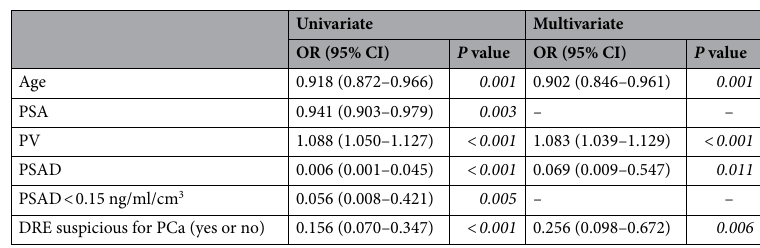
Table 2. Predictors of absent PB detected, CSPCa in men with negative MRI. OR odds ratio, PSA prostate specific antigen, PV prostate volume on MRI, PSAD PSA density, DRE digital rectal examination.